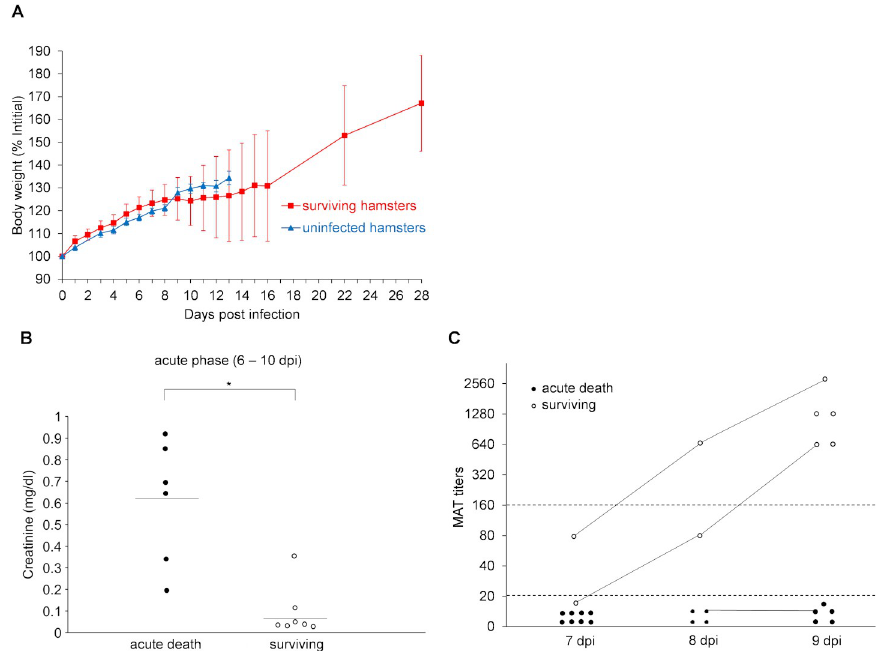
Fig 3. The changes in body weight, serum creatinine levels and antibody titers of moribund and surviving hamsters in the acute phase. (A) The changes in body weight of uninfected control hamsters (blue triangles, n = 8) and surviving hamsters subcutaneously infected with 1 × 10 4 cells of L . interrogans serovar Manilae strain UP-MMC-SM (red squares, n = 15) were compared with the body weight on 0 dpi as 100%. Error bars indicate mean ± SD. (B) The serum creatinine levels in the acute phase (6–10 dpi) were compared between hamsters that became moribund in the acute phase (“acute death” black circles, n = 6) and those that survived (“surviving” white circles, n = 7). Moribund hamsters showed higher serum creatinine levels than surviving hamsters. The average value for each group is indicated by a bar. Mann-Whitney U test was used for comparison between the two groups ( p = 0.006). The significance level was p < 0.05. (C) The antibody titers by microscopic agglutination test (MAT) titers in the acute phase (6–10 dpi) were compared between hamsters that became moribund in the acute phase (“acute death” black circles, n = 16) and those that survived (“surviving” white circles, n = 5, 9 samples). The MAT titers of multiple samples obtained from a hamster are connected by a line. � p < 0.05 between groups.